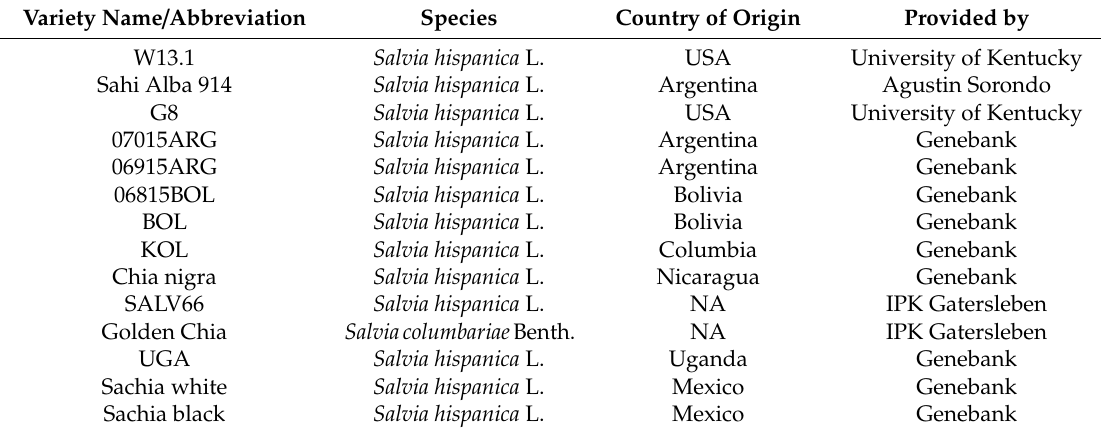
Table 1. 13 Salvia hispanica L. varieties and one Salvia columbariae Benth. variety were cultivated during a climate chamber trial at the University of Hohenheim in 2015 /